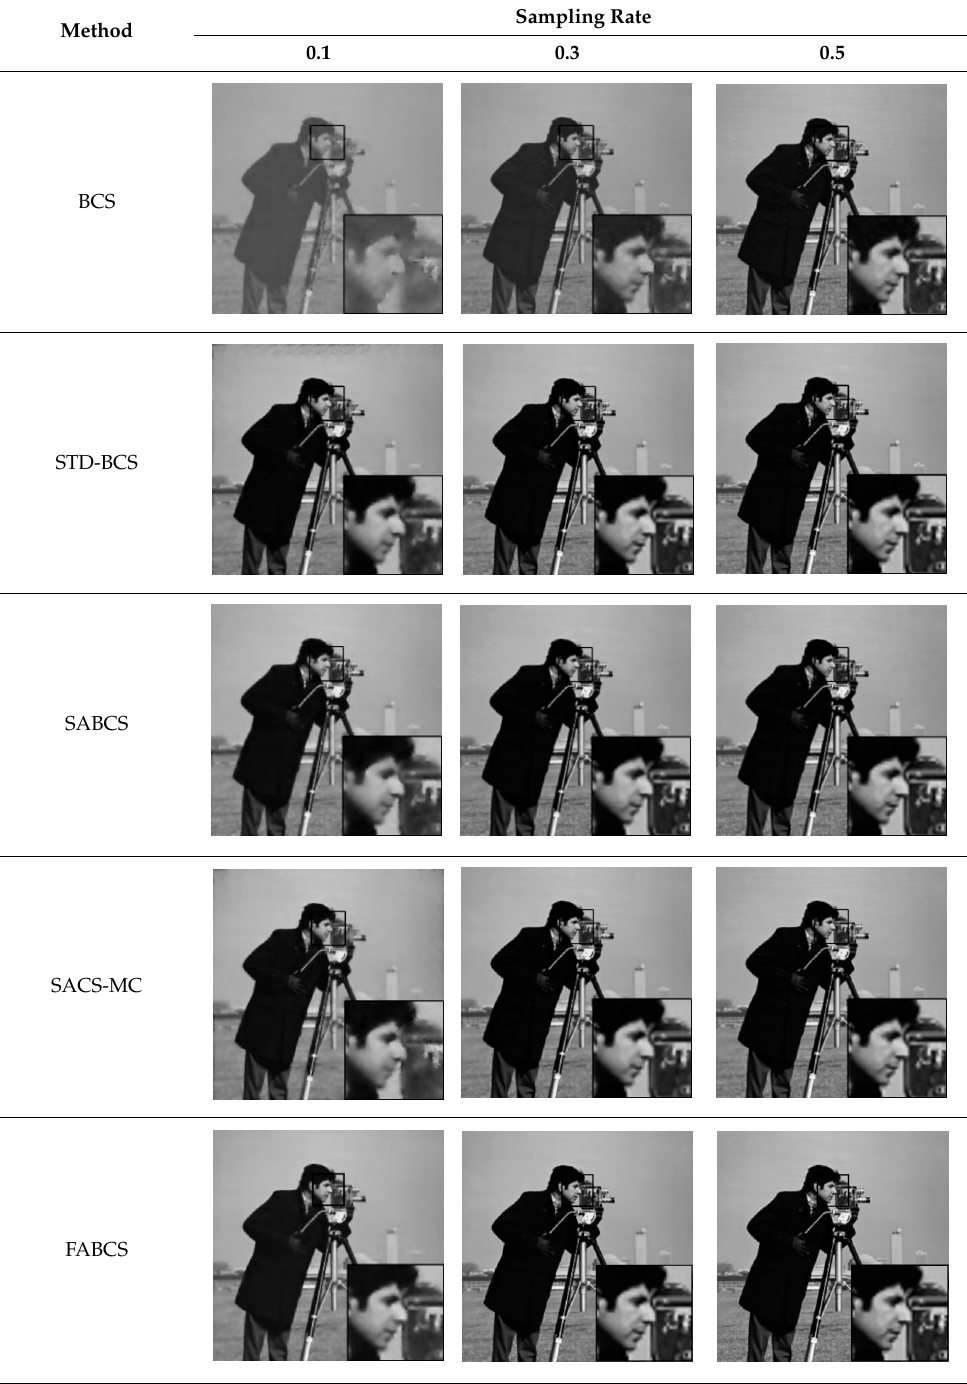
Table 6. Image of the ABCS algorithm at different sampling rates (32 x 32 block size).